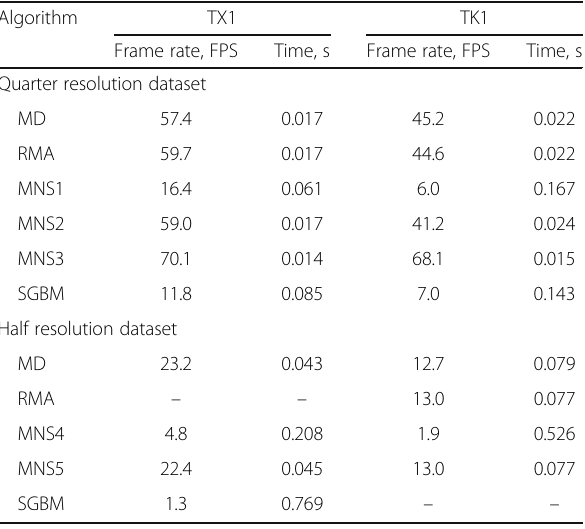
Table 5 The average frame rate and processing time of each algorithm. Evaluation was performed on both Jetson boards.